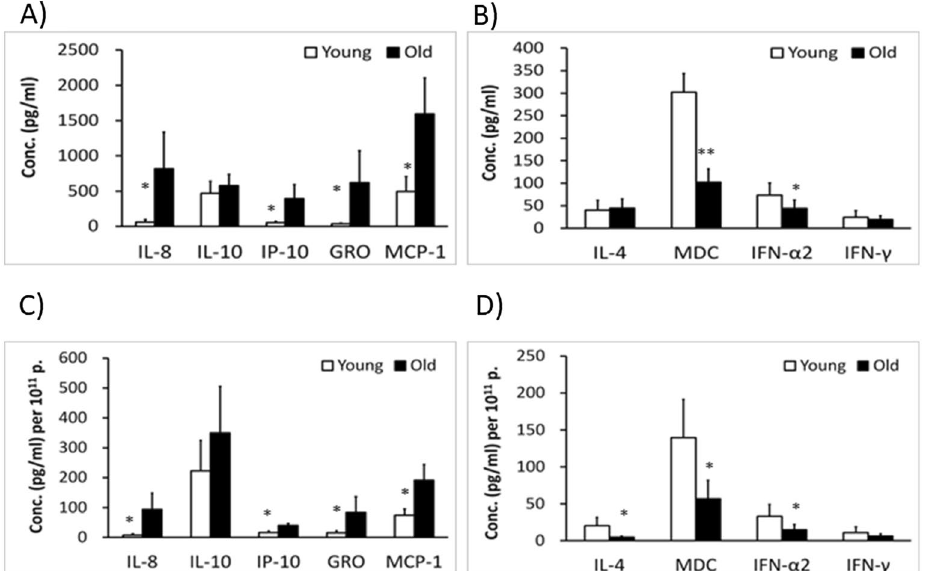
Figure 3. Different SASP and defense factors of urine EVs between young (n = 10) and old (n = 10) adults. UEV derived from the elderly had significantly higher IL-8, IP-10, GRO and MCP-1 levels ( A ) and significantly lower levels of defense factors: IFNα and MDC before normalization ( B ). After the normalization with individual number of EVs, UEV derived from the elderly had significantly higher IL-8, IP-10, GRO and MCP-1 levels ( C ), and significantly lower IL-4, IFNα and MDC levels ( D ). Data are presented with mean ± SE and Mann Whitney U test is used to estimate the significance. *Indicates a significant difference at p < 0.05, and **indicates a significant difference at p <